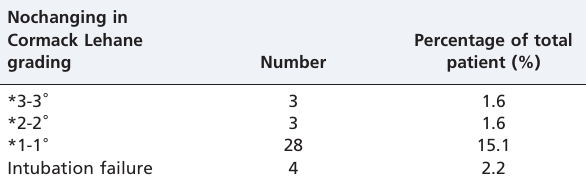
Table 4 - No change in Cormack-Lehane